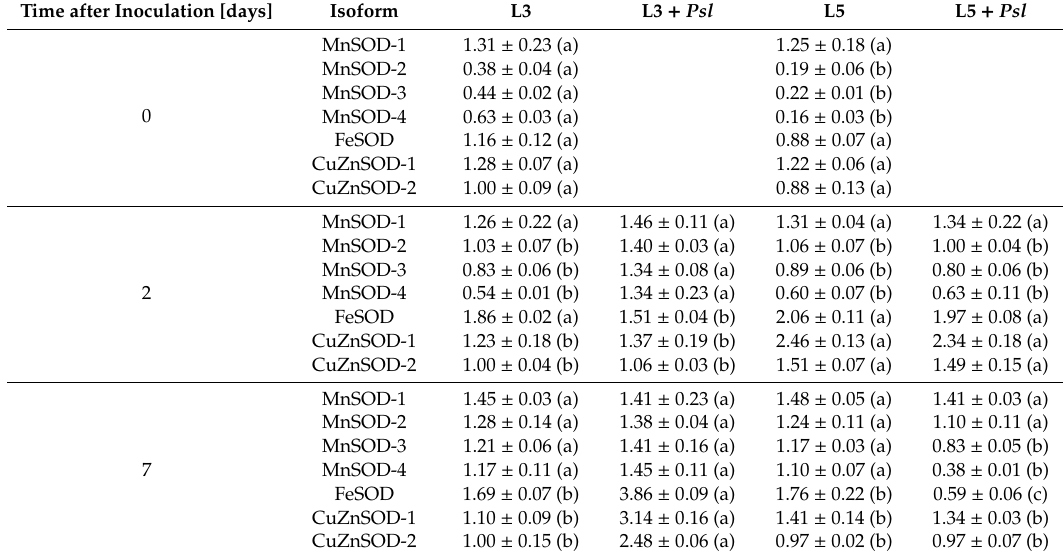
Table A1. Relative activities of superoxide dismutase (SOD) isoforms after native gel electrophoresis (PAGE).